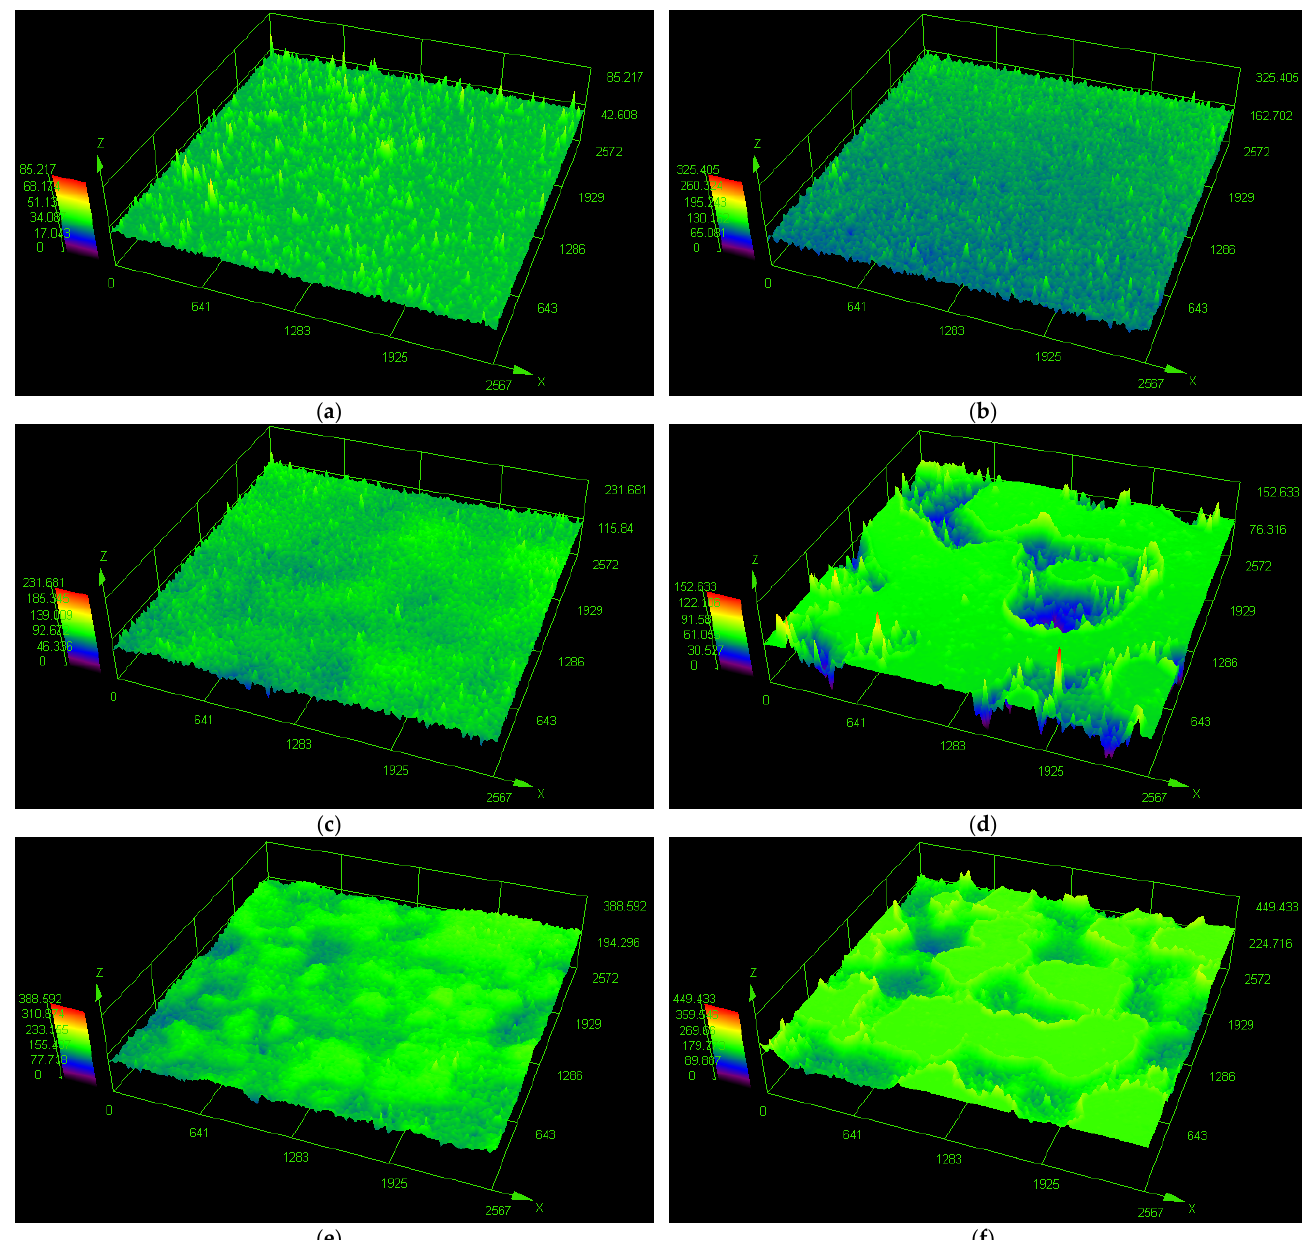
Figure 8. Optical maps of the tile surface: ( a ) S1, ( b ) S2, ( c ) S3, ( d ) S4, ( e ) S5, and ( f ) S6.